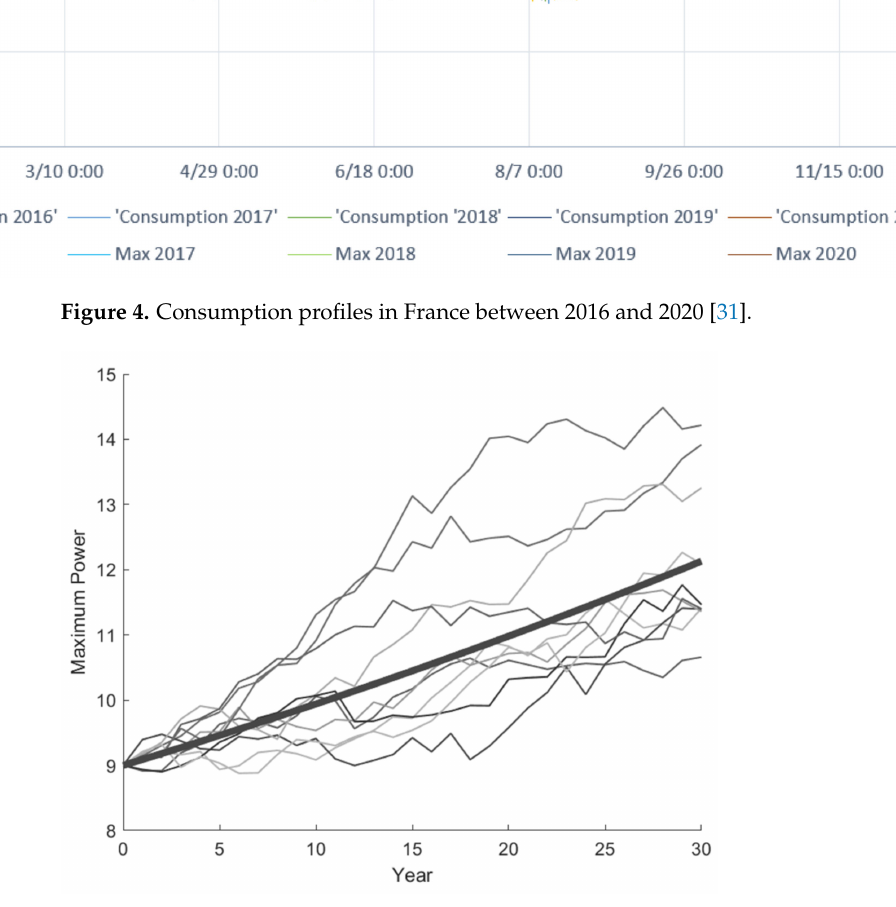
Figure 5. Geometric Brownian motion evolution vs. deterministic evolution (bold